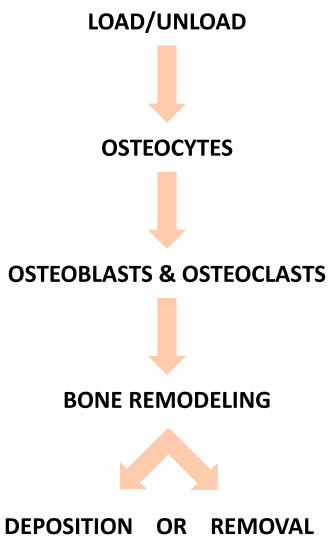
Figure 2. The orchestrated mechanism of